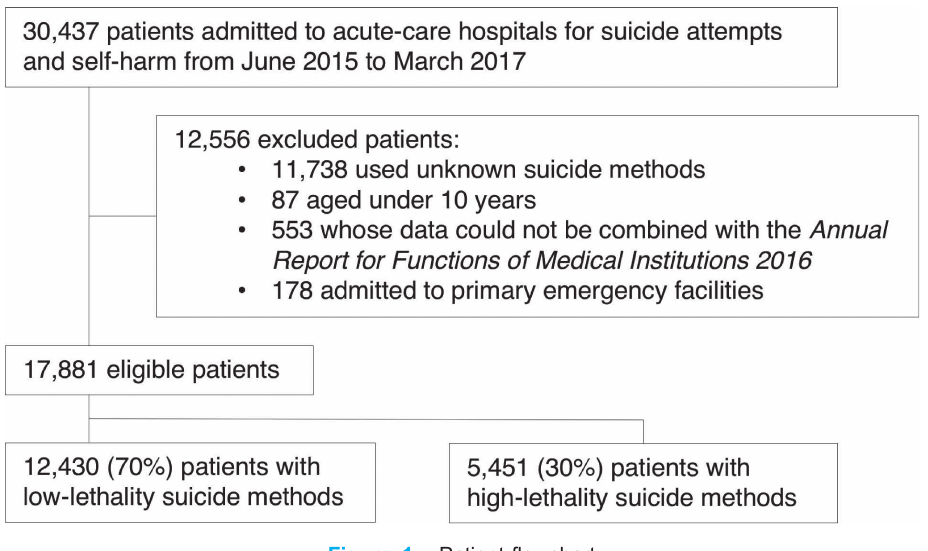
Figure 1. Patient fl